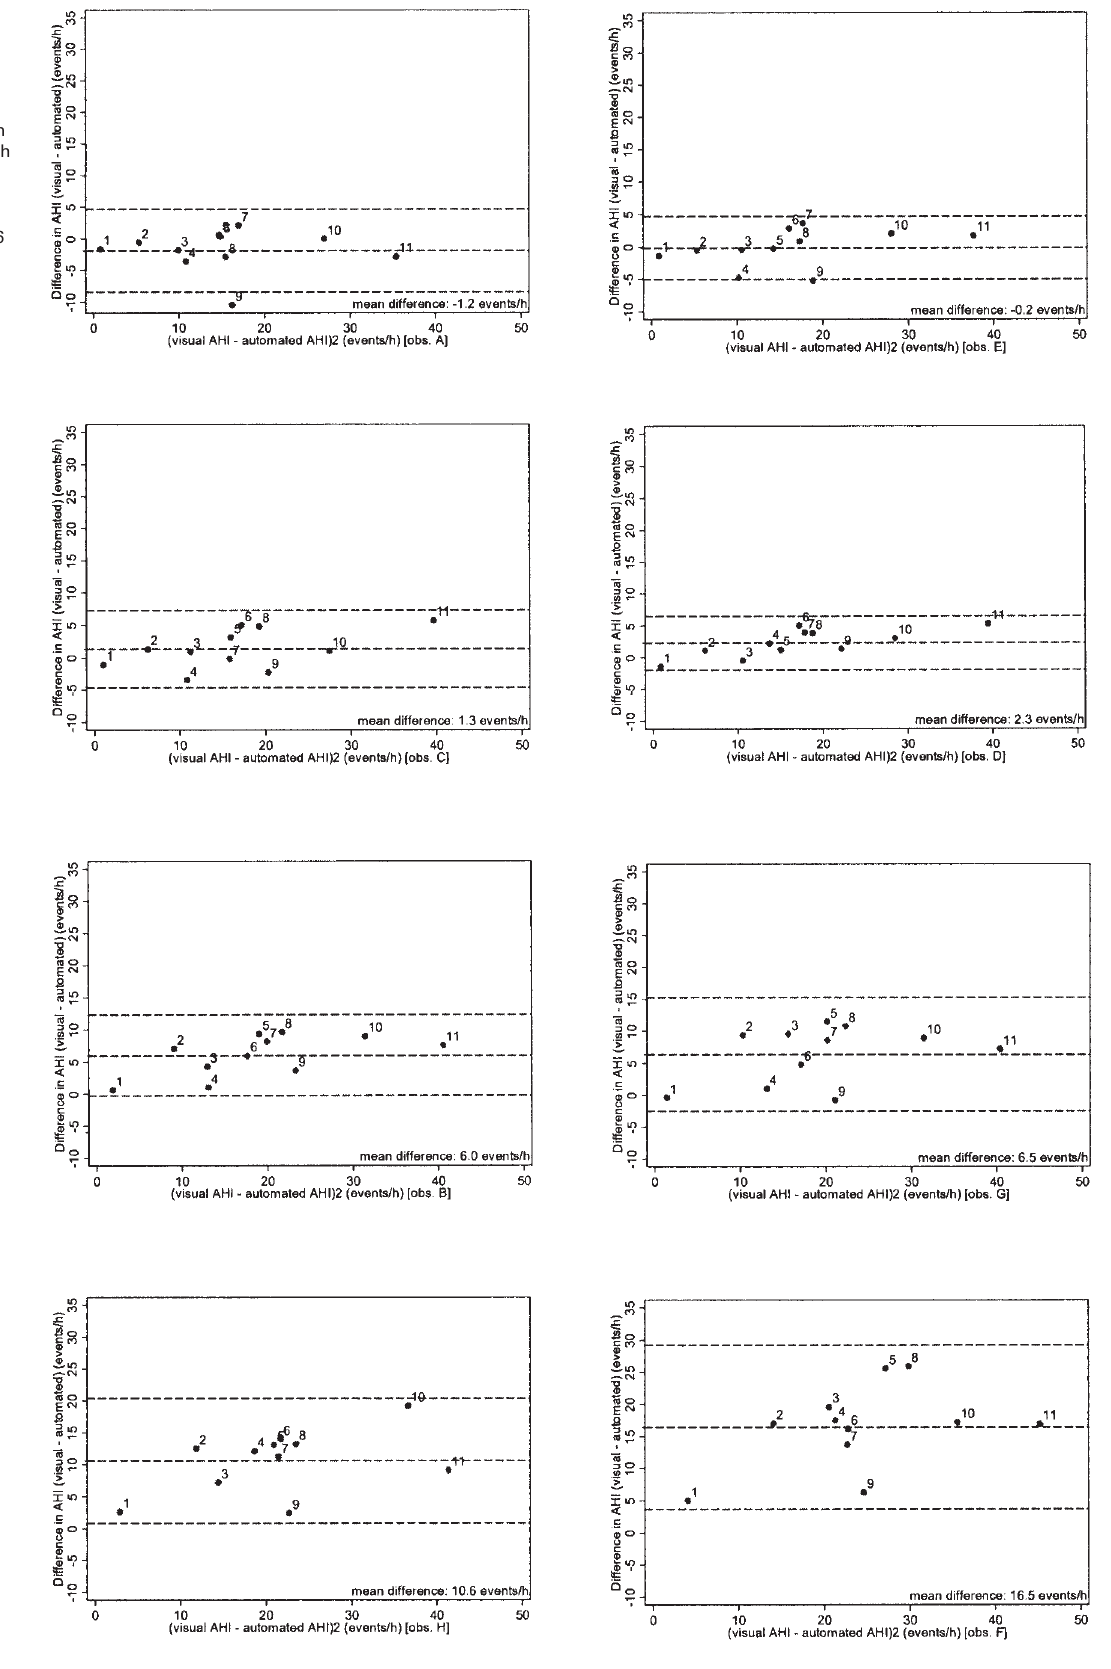
Bland Altman plots illustrating system- atic differences between visual and automated scores on apnoea lines on each plot represent the mean difference (visual – automated analysis) and +/- 1.96 SD of the difference. label 1-11: patients; AHi: apnoea hypop- noea